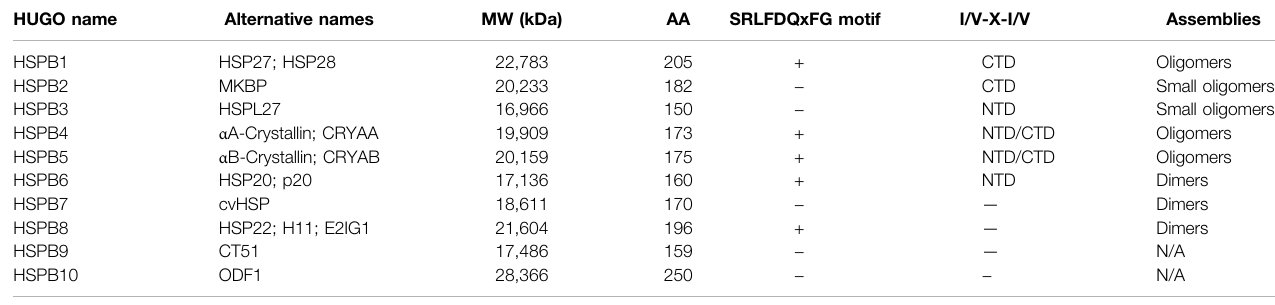
TABLE 1 | Nomenclature and properties of HSPBs. The table lists HSPBs, their alternative names and properties. The molecular weight (MW), aminoacidic length (AA) and oligomerization propensity are reported. The presence of the SRLFDQxFG and the I/V-X-I/V motifs are reported. NTD and CTD refer to the N and C-terminal domains, respectively; N/A means not assessed.